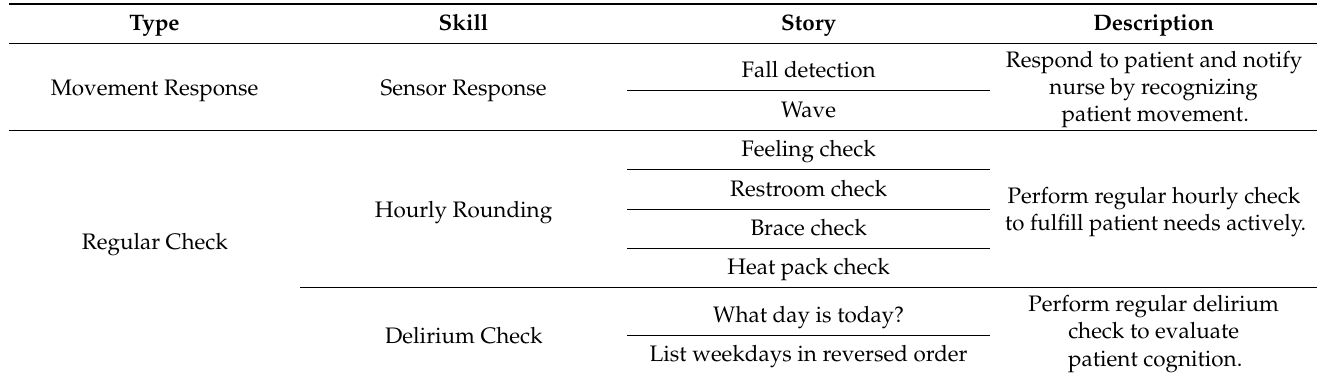
Table 1. Seva skills in the